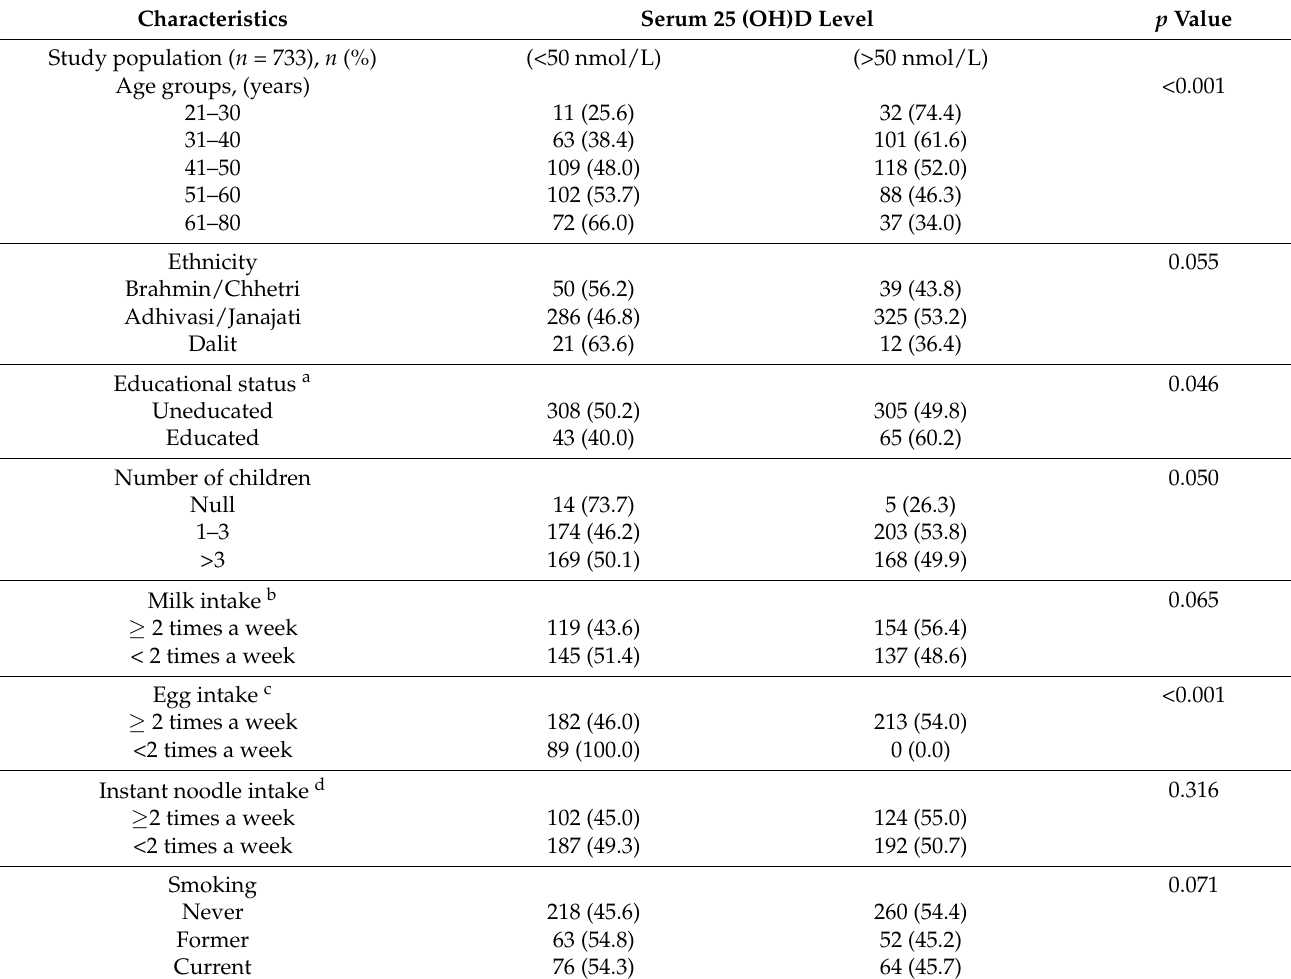
Table 2. Prevalence of hypovitaminosis D by sociodemographic and lifestyle factors.